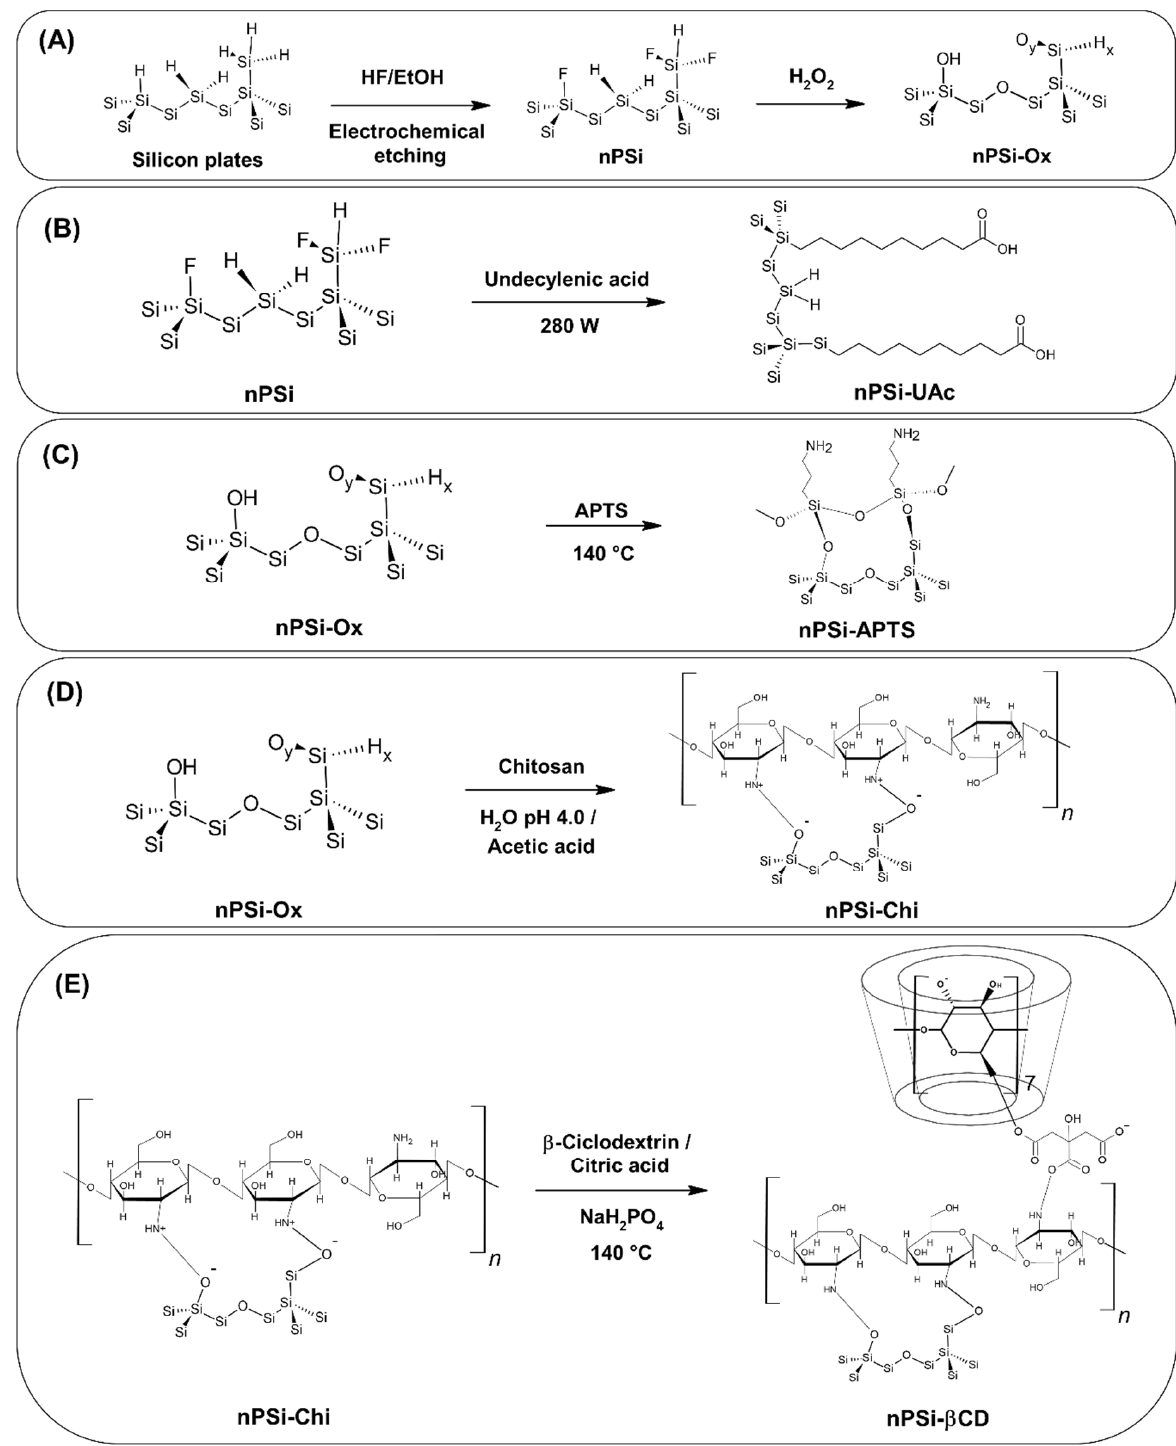
Figure 3. Nanostructured porous silicon (nPSi) synthesis and functionalization process. ( A ) nPSi synthesis and oxidation reaction (nPSi-Ox); ( B ) nPSi/Undecylenic acid reaction (nPSi-UAc); ( C ) nPSi-Ox/APTS reaction (nPSi-APTS); ( D ) nPSi-Ox Chitosan reaction (nPSi-Chi) and ( E ) nPSi-ox/βCD reaction (nPSi-βCD).